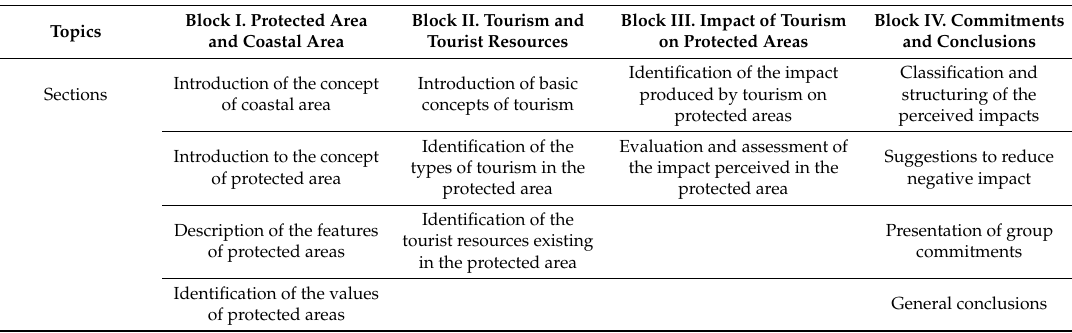
Table 2. Presentations structure.